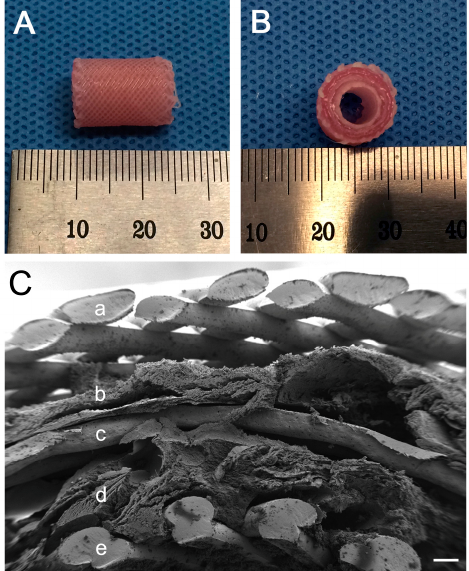
Figure 2. 3D bioprinted artificial trachea. ( A ) Longitudinal view, 15 mm in length. ( B ) Vertical view, five-layered structure with a 5-mm inner diameter and 10-mm outer diameter. ( C ) Magnified structure of the scaffold (SEM image). (a,c,e) layers are composed of PCL. (b) is alginate layer with MSC or d-MSC and (d) is alginate layer with epithelial cells. The innermost (e) and outermost (a) layers showed a microporous feature. The non-porous third layer (c) separates the epithelial cell layer (d) and the MSC or d-MSC layer (b). The scale bar indicates 200 µm.